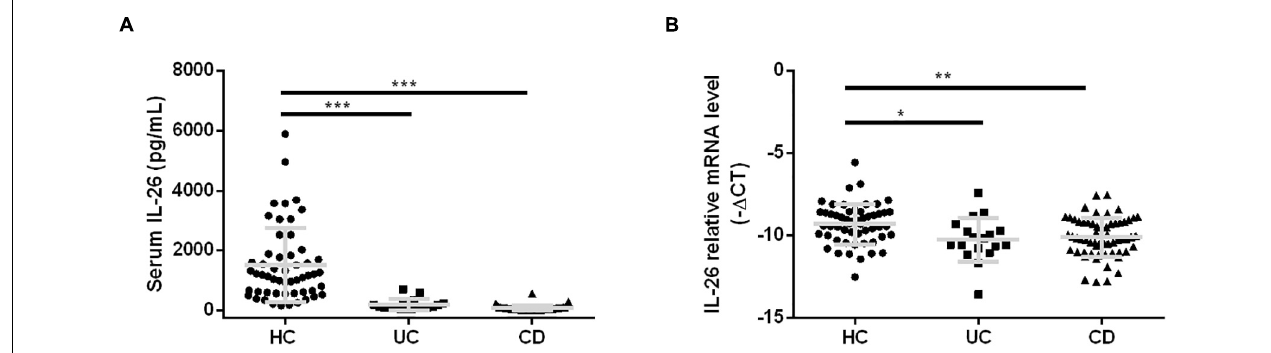
FIGURE 2 | IL-26 expression levels in serum and PBMCs were reduced in IBD patients. IL-26 expression levels in serum (A) and PBMCs (B) in UC patients, CD patients and healthy controls (HC). * P < 0.05, ** P < 0.01, *** P < 0.001.